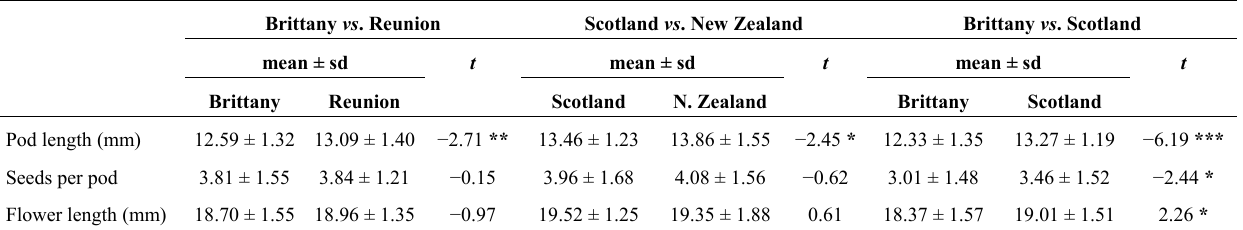
Table 2. Characteristics of Ulex europaeus pods and flowers used in each choice experiment, and results of Student’s t -test for pairwise comparisons of means. Brittany vs . Reunion Scotland vs . New Zealand Brittany vs . Scotland mean ± sd t mean ± sd t mean ± sd t Brittany Reunion Scotland N. Zealand Brittany Scotland Pod length (mm) 12.59 ± 1.32 13.09 ± 1.40 −2.71 ** 13.46 ± 1.23